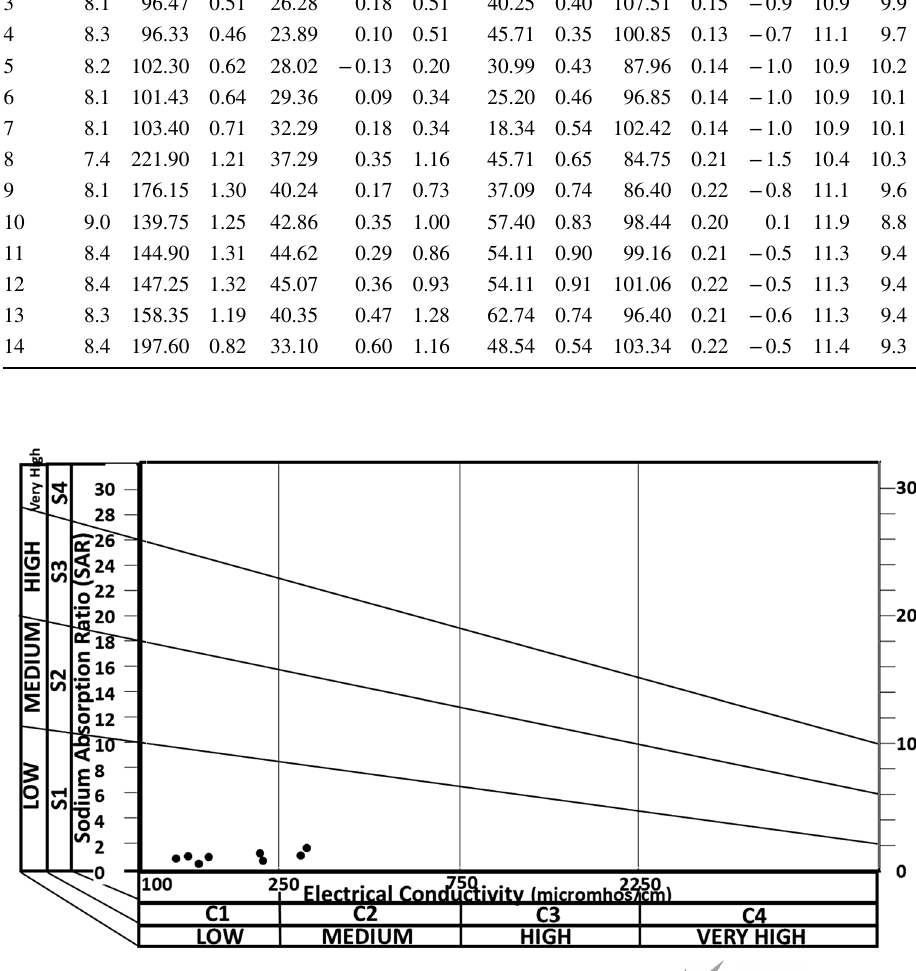
indices of post-monsoon season for water quality assessment